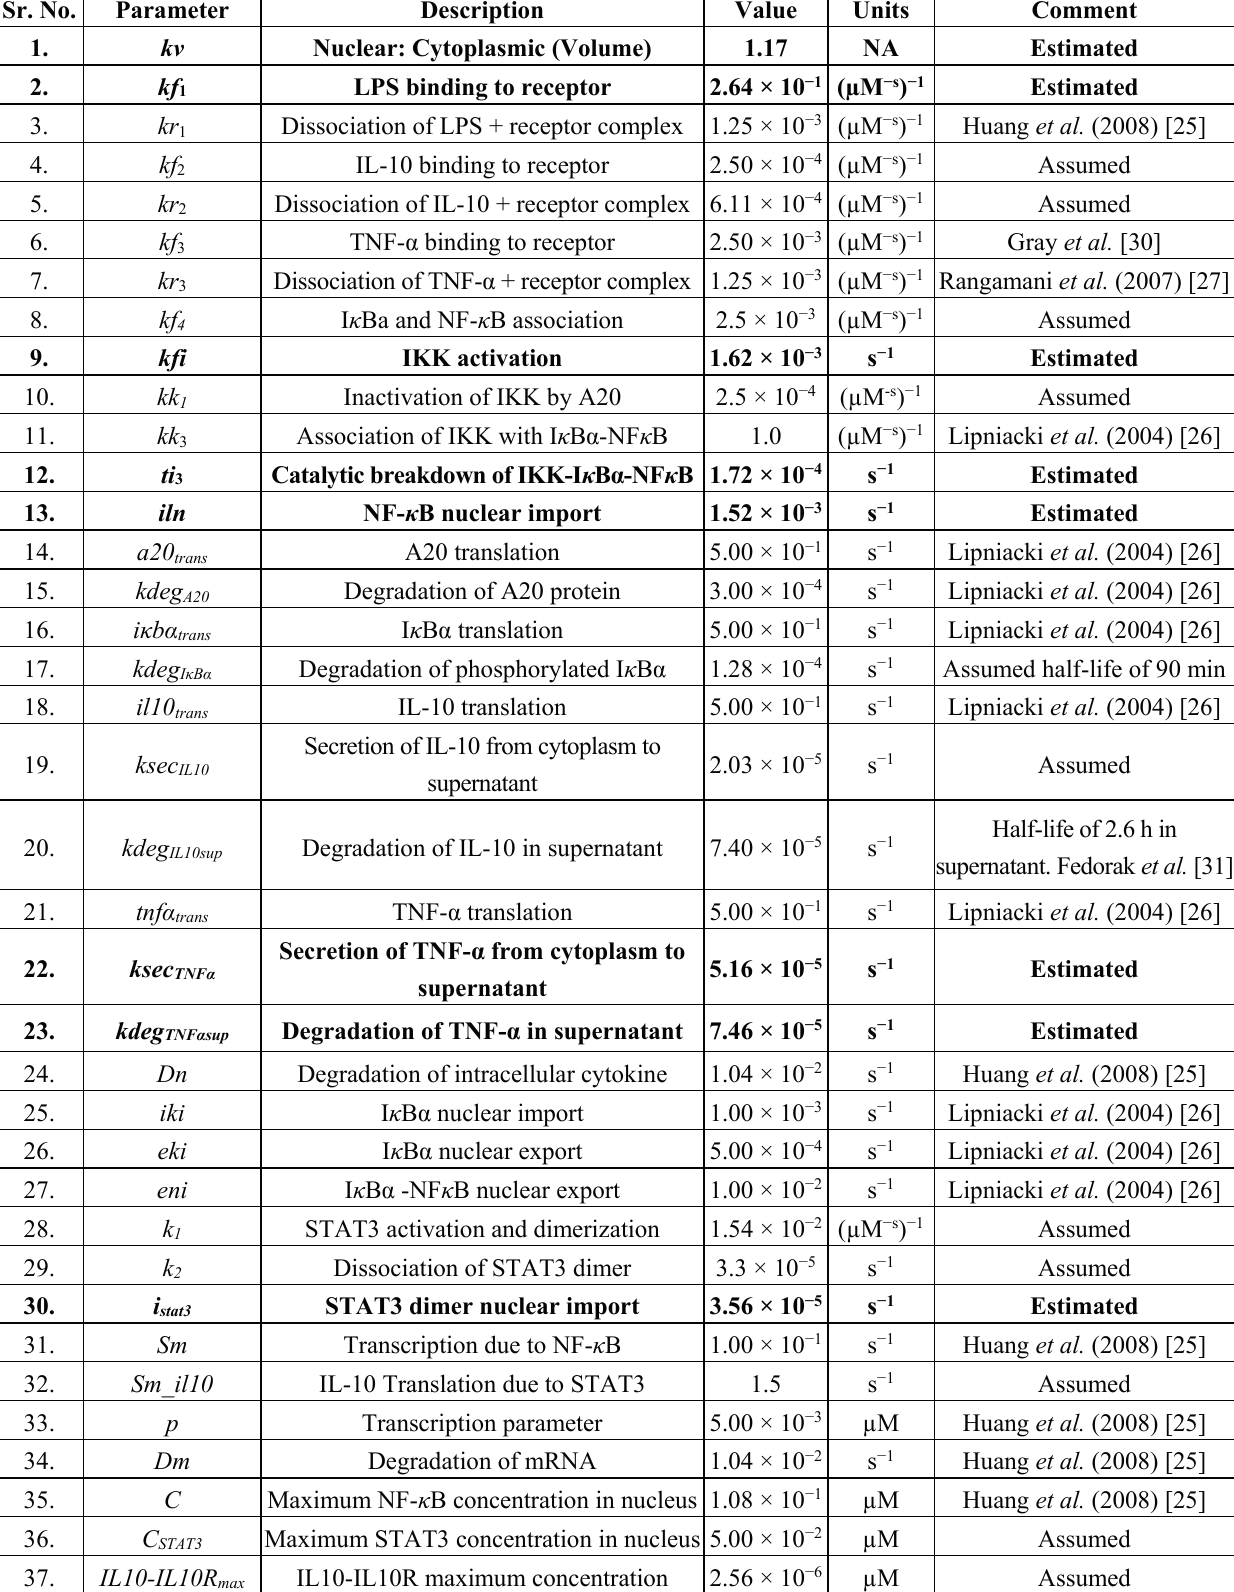
Table 2. List of parameters used in the ODE